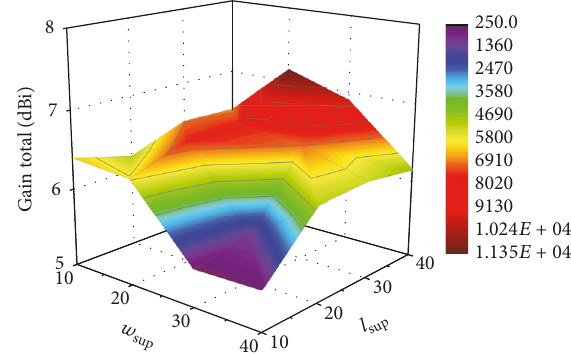
Figure 6: Gain total variation of Antenna #2 for different combina- tions of 𝑙 sup and 𝑤 sup (at 𝑎 1 = 0.189 𝜆 0